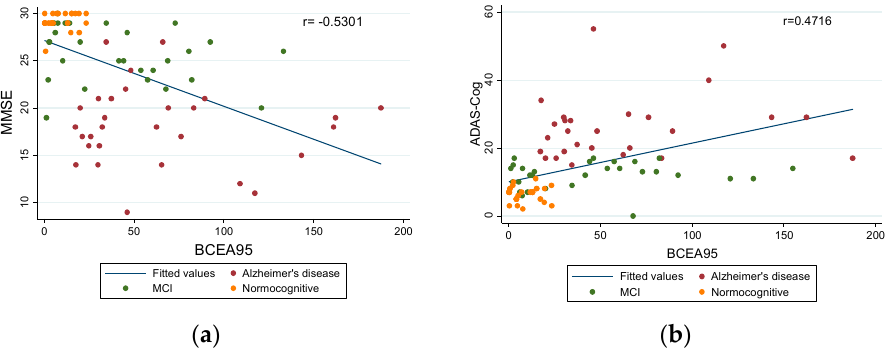
Figure 3. Linear regression graphs between: ( a ) Mini-mental State Examination (MMSE) and BCEA95; ( b ) Alzheimer’s Disease Assessment Scale-Cognition subscale (ADAS-Cog) and BCEA95.